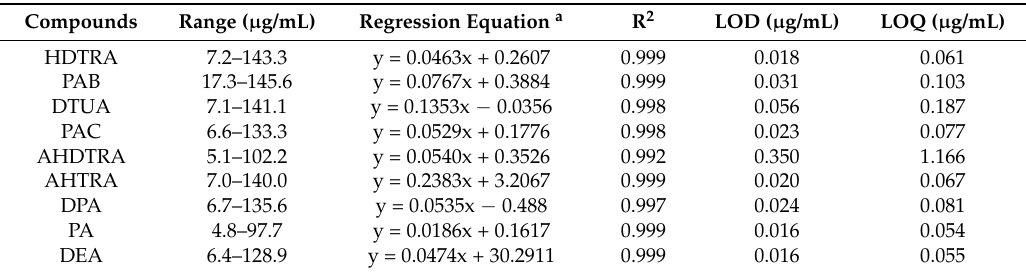
Table 1. Linear regression, limit of detection (LOD) and limit of quantification (LOQ) of investigated triterpene acids.